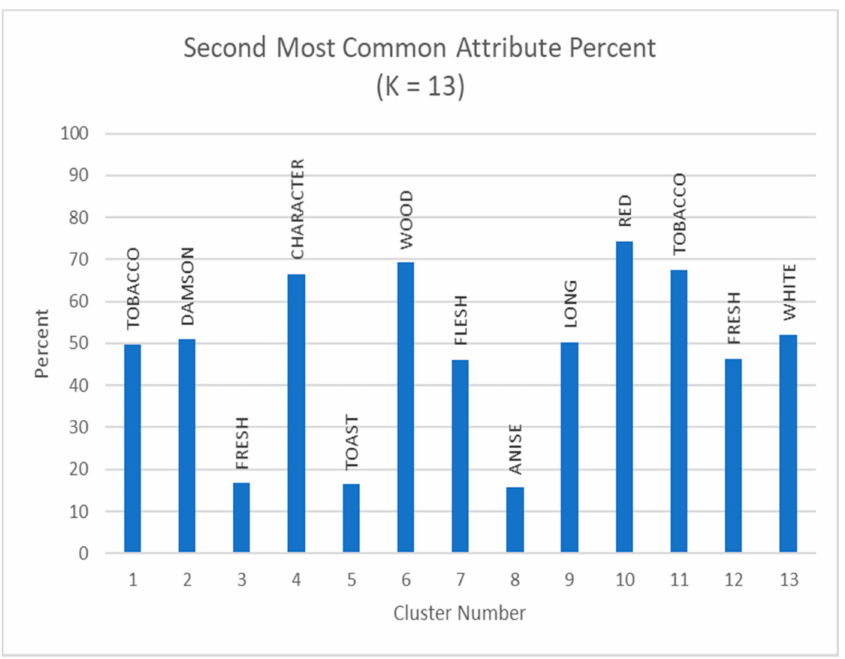
Figure 13. Second most common attributes in clusters when K = 13. The percentages shown do indicate that the increased populations of the clusters affect the common attributes of the clusters to an extent. A general decrease in percentage can be noted when utilizing a smaller K value.